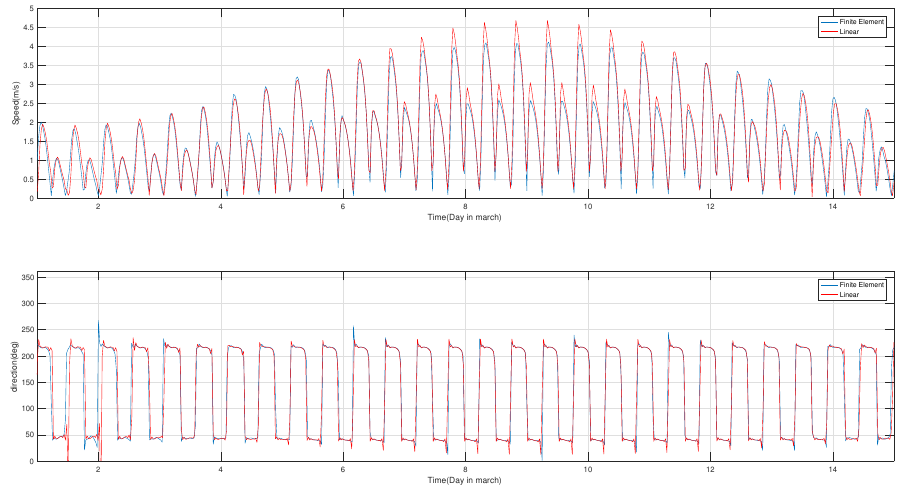
Figure 4. Time series of the predicted depth-averaged amplitude and direction (anticlockwise convention from the east) of the current at point #1 in neap-spring tidal cycle.